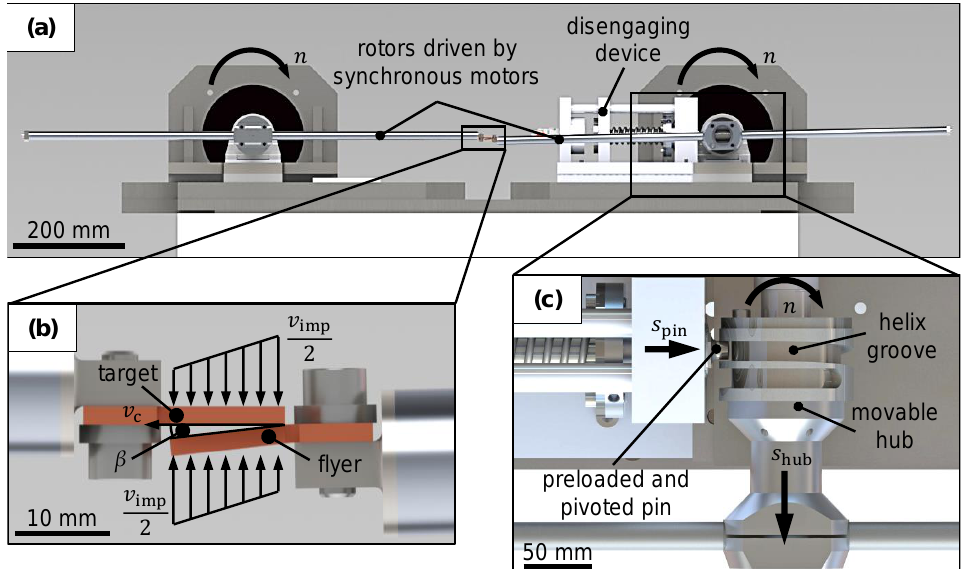
Figure 1. The model test rig ( a ) consisted of two synchronous motor-driven rotors and a disengaging device. A sample ( b ) was attached to one end of each rotor, one of which is pre-bent to determine the collision angle. In the disengaging device a pivoted pin ( c ) is preloaded by an electric holding magnet. When the magnet is switched off, the pin engages the helix groove ( s pin ) and the entire rotor hub ( s hub ) is extended within one